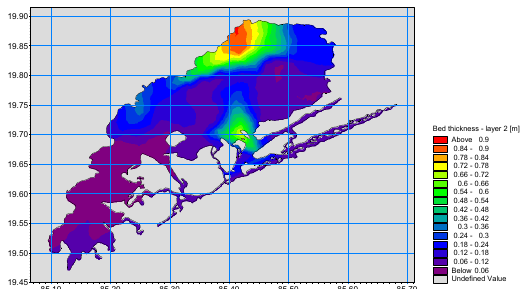
Figure 7c. Simulated spatial profile of Bed thickness-layer